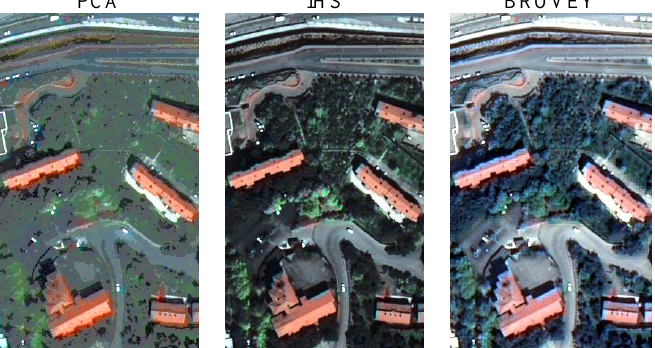
Figure 1. Pan-sharpened images generated by various methods.